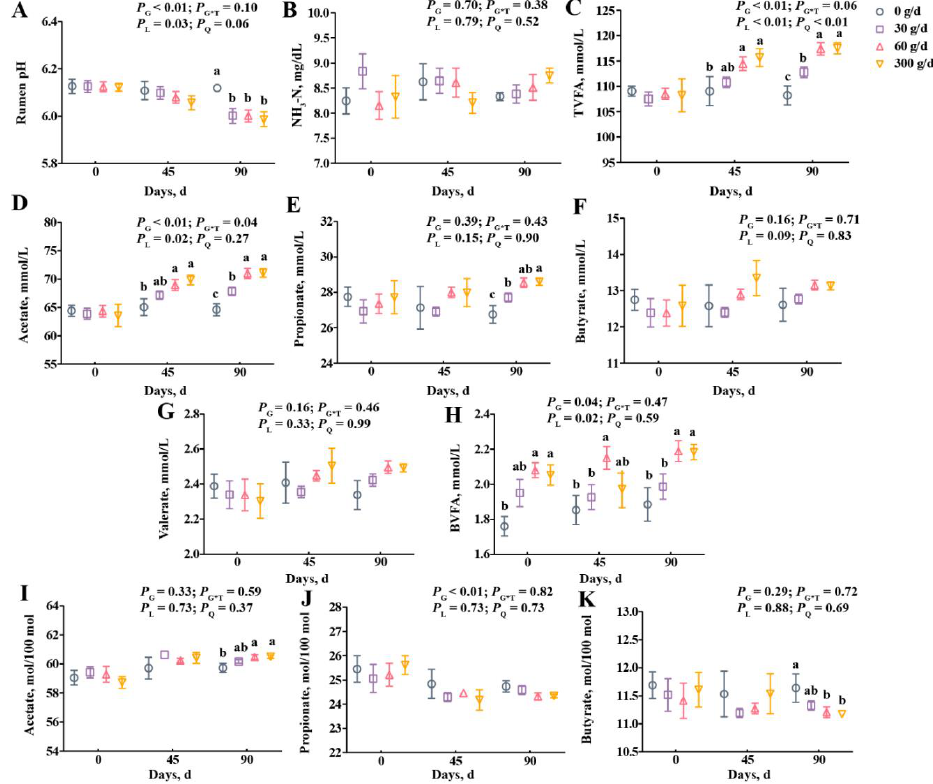
Figure 2. Effects of different amounts of Acremonium terricola culture on rumen pH ( A ), NH 3 -N ( B ), and volatile fatty acids ( C – K ) in lactating dairy cows. The VFA are expressed as concentration ( C – H ) and molar proportion ( I – K ). The effects included group effect and the interaction effect of group and time, as well as linear and quadratic effects. Different lowercase letters denote significant dif- ferences among treatments ( p < 0.05). ATC, Acremonium terricola culture; TVFA, total volatile fatty acid; BVFA, branched volatile fatty acid; Mean ± SEM. n = 15 .